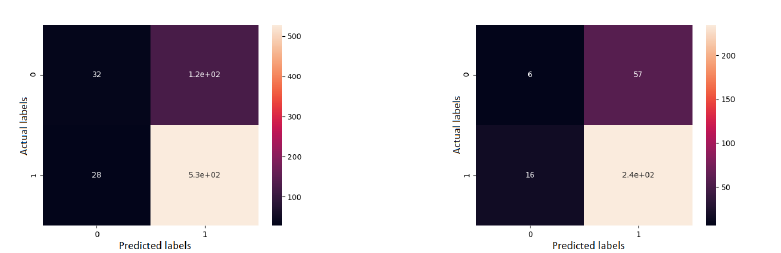
Figure 9. Confusion matrix results for the disease evolution classification using gradient boosting classifier. Label 0 represents a good disease evolution, while 1 stands for a poor evolution. The matrix column represents the actual